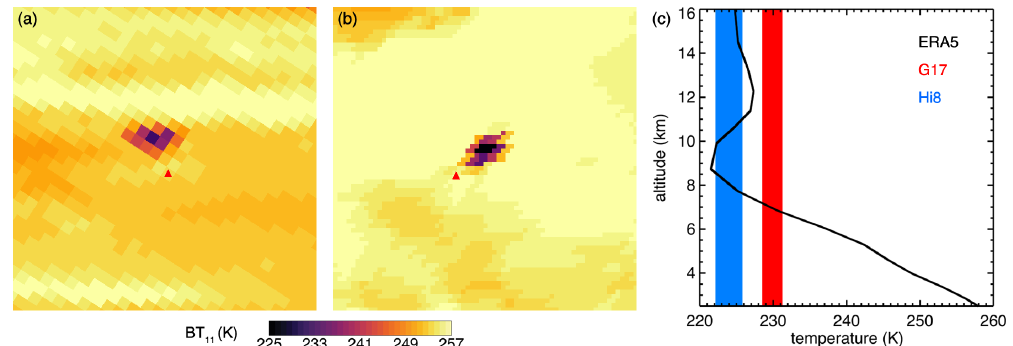
Figure 5. Band 14, 11.2µm brightness temperature (BT 11 ) image of the 8 April 2020 eruption of Sheveluch at 19:10UTC from (a) GOES-17 fixed grid data and (b) Himawari-8 CEReS V20190123 gridded and resampled data (0.02 ◦ or ∼ 2km resolution). The red triangle marks the volcano base. In panel (c) the black line is the ERA5 temperature profile above the vent (2.5km altitude). The red and blue shaded areas respectively indicate the range of the GOES-17 and Himawari-8 minimum BT 11 between 19:10UTC (warmest dark pixel) and 19:50UTC (coldest dark